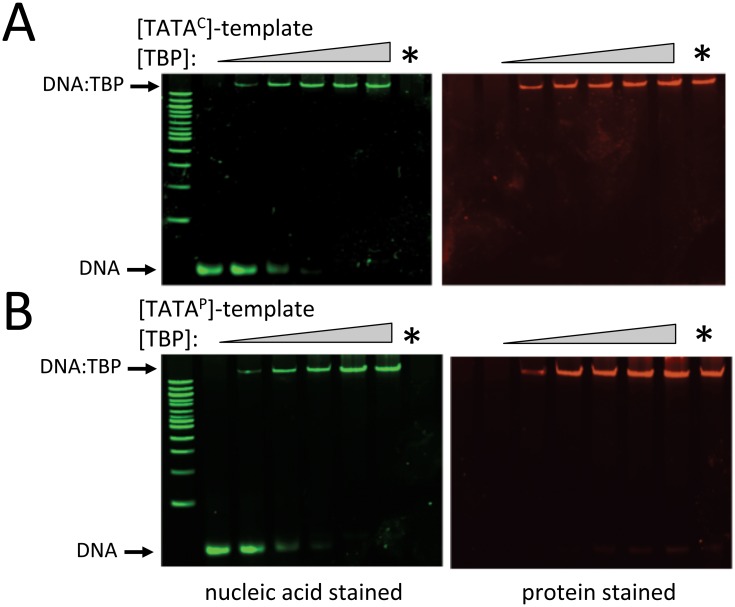
EMSA analysis of BbTBP binding to TATA-containing oligonucleotides.(A) Binding of purified BbTBP to TATAC-template. Increasing concentrations of BbTBP (0, 280, 560, 1120, 1680, and 1960 nM) were incubated with TATAC-template (16.8 nM) and analyzed on 6% non-denaturing PAGE as detailed in the Methods section. Lanes labeled with an asterisk; 1680 nM BbTBP with no template. Left panel, gel visualized with nucleic acid strain (green), right panel, gel visualized with protein stain (red). (B) Binding of purified BbTBP to TATAP-template. Increasing concentrations of BbTBP (0, 280, 560, 1120, 1680, and 1960 nM) were incubated with TATAC-template (18.3 nM) and analyzed on 6% non-denaturing PAGE as detailed in the Methods section. Lanes labeled with an asterisk; 1680 nM BbTBP with no template. Left panel, gel visualized with nucleic acid strain (green), right panel, gel visualized with protein stain (red).